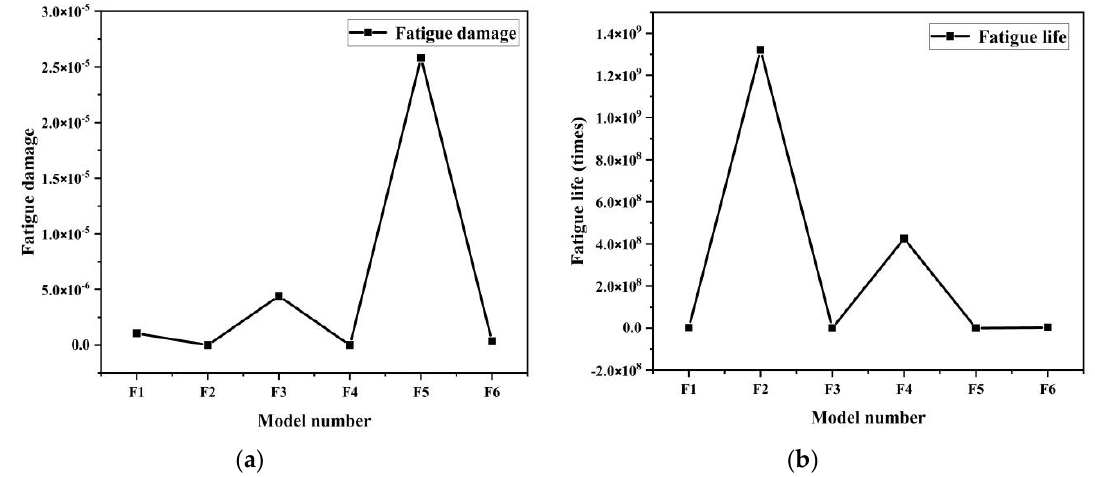
Figure 14. Variation curves of ( a ) fatigue damage and ( b ) fatigue life of six models.